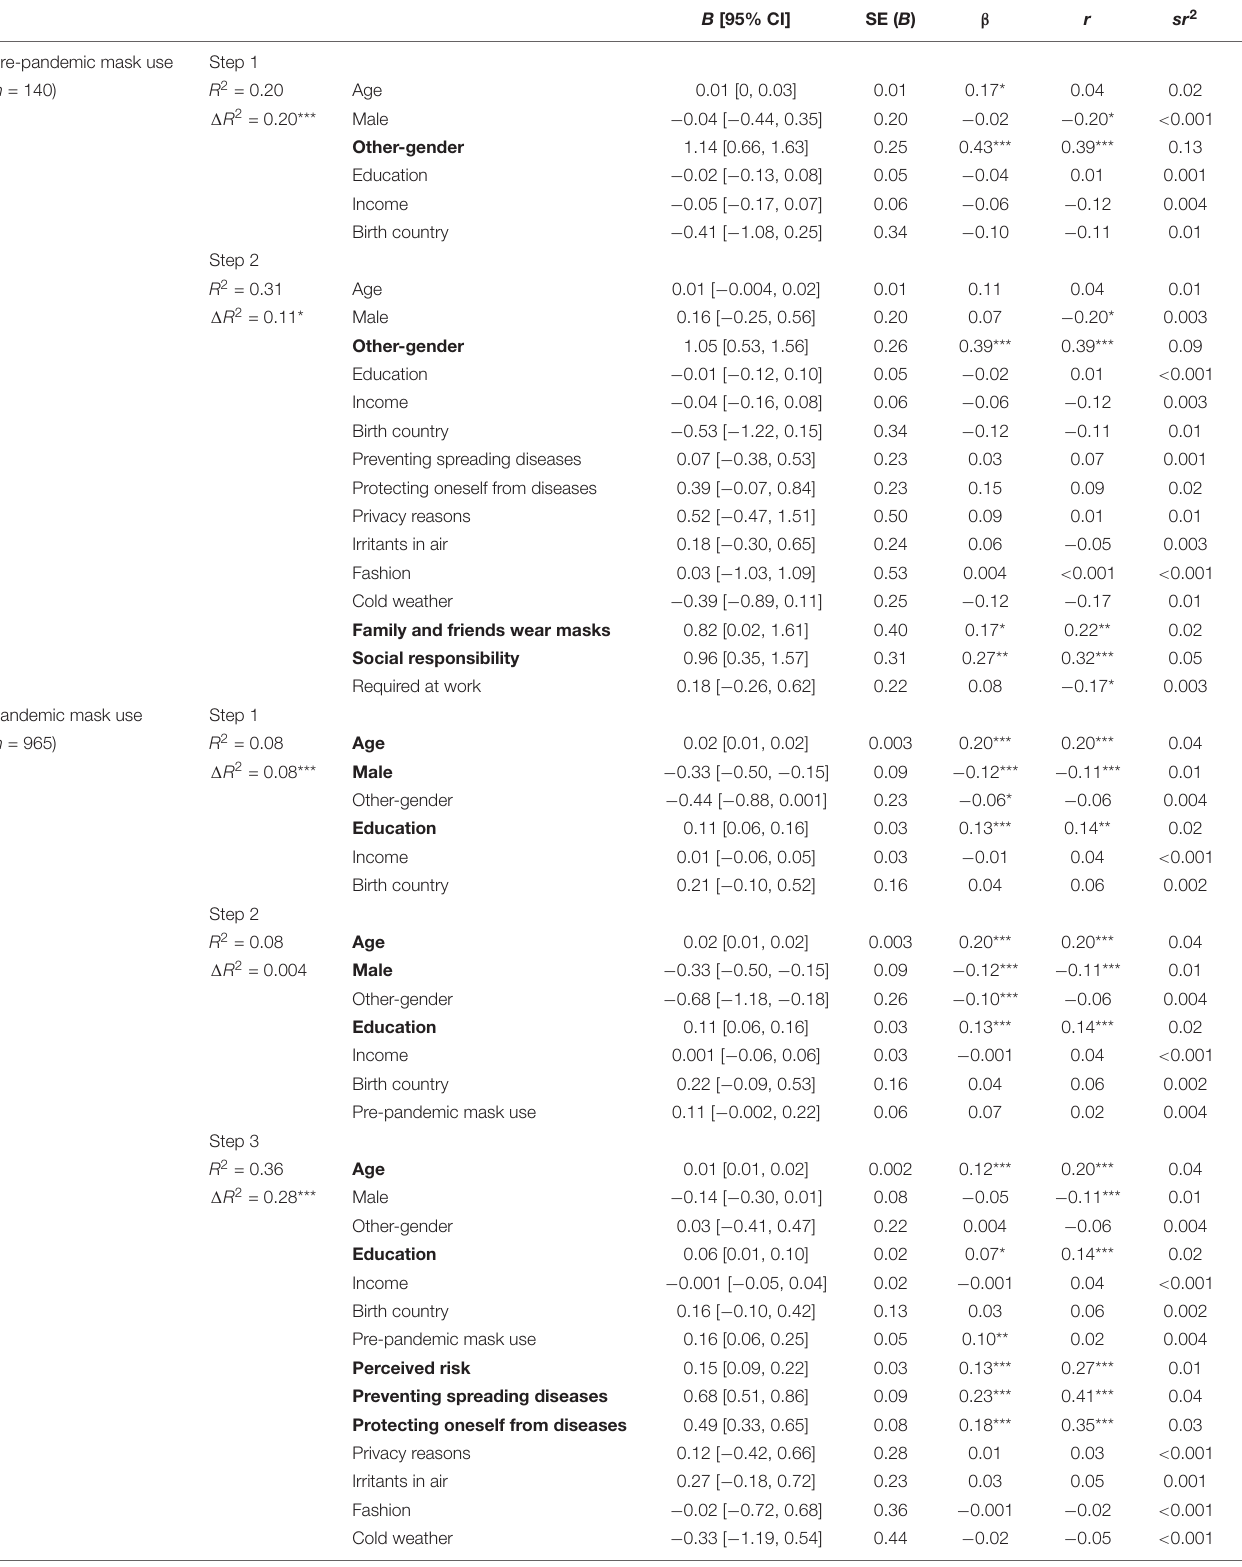
B [95% CI] SE ( B ) β sr 2